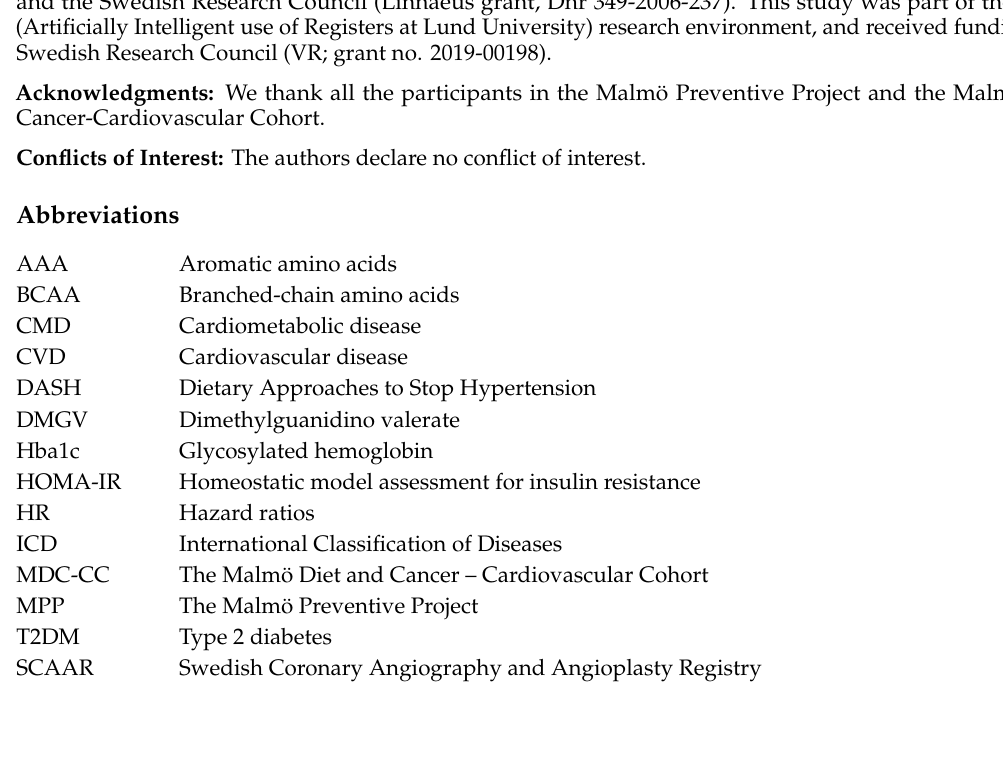
Figure S1: Study design of the Malmö Diet and Cancer—Cardiovascular Cohort (MDC-CC) and the Malmö Figure S4: Annotation of 1-methyladenosine, Figure S5: Annotation of Dimethylguanidino valerate (DMGV), Figure S6: Annotation of Urobilin, Figure S7: Annotation of N2,N2-dimethylguanosine, Figure S8: Annotation of Hippurate, Figure S9: Annotation of Homocitrulline, Figure S10: Annotation of Lysine, Figure S11: Annotation